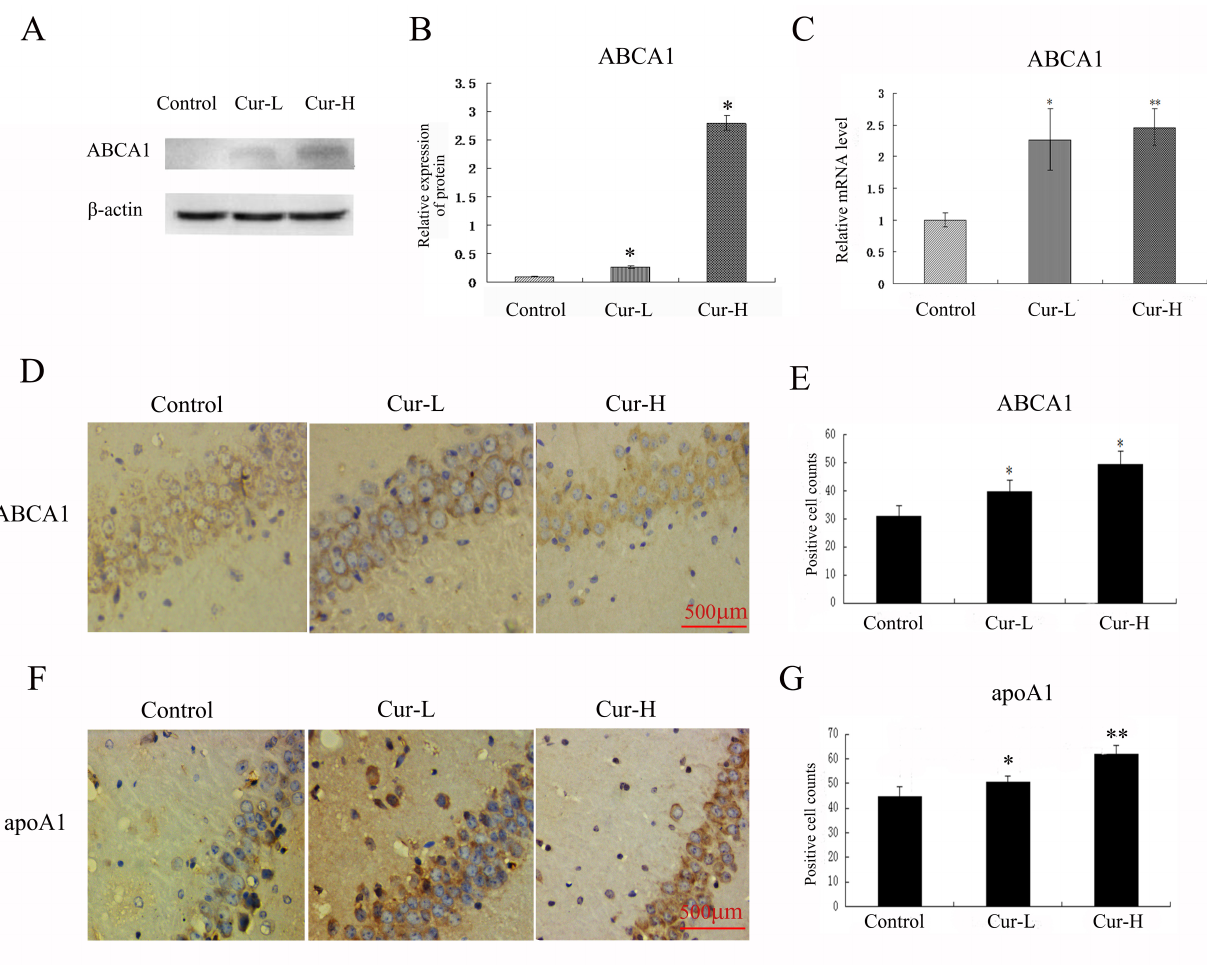
Fig. 4. Curcumin promoted the ABCA1 expression and apoA1 in the hippocampus of APP/PS1 mice. (A–C) Western blot and RT-PCR analysis to ABCA1ofeachgroup. (D–G)ImmunocytochemistryanalysisofABCA1andapoA1ineachgroup(Scalebar=500 µ m). Thedataaremean ± SEMofatypical three experimental series (* p < 0.05, versus Control; ** p < 0.01, versus